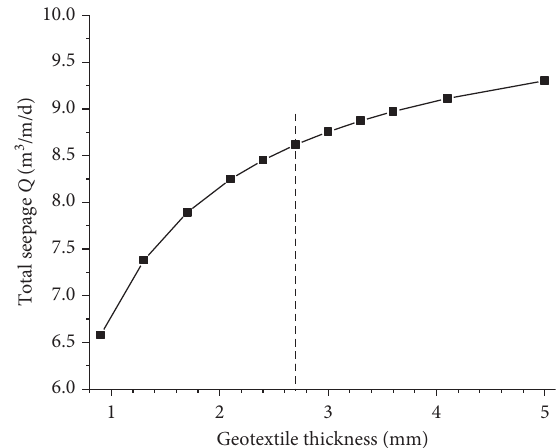
Figure 9: Relationship between geotextile thickness and water